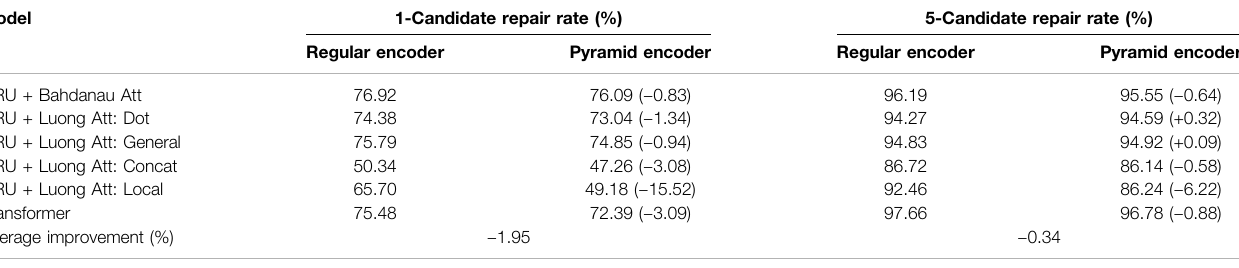
TABLE1| RepairrateofGRUandTransformeronJulietTestSuiteforC/C++,comparingtheregularencoderandpyramidencoder.Theseresultsareaveragedovera4-fold cross-validation. We calculated the improvement of pyramid encoders compared to their nonpyramid pairs. Apparently pyramid encoder does not collaborate well with Luong ’ s local attention; therefore, we exclude it from future discussions. It is also not included when calculating the average improvement. Model